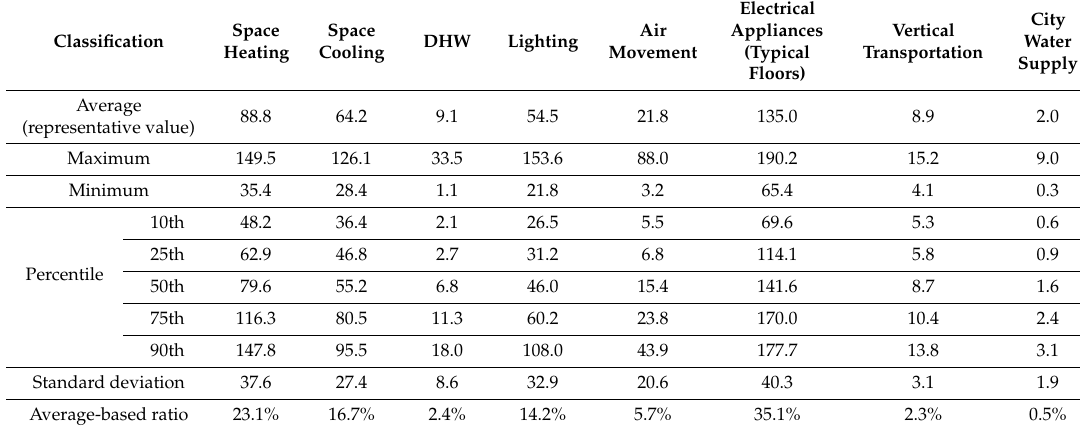
Table 13. Statistics of primary EUIs (kWh / m 2 · year).